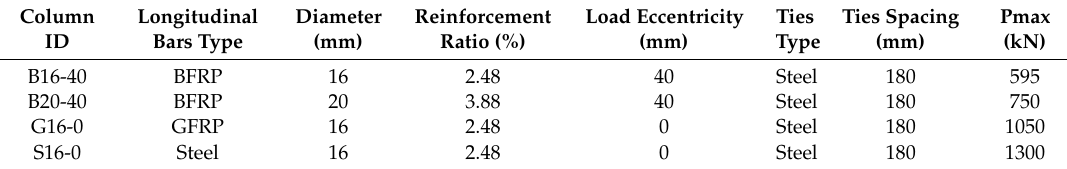
Table 4. Test matrix, specimens’ details, and results